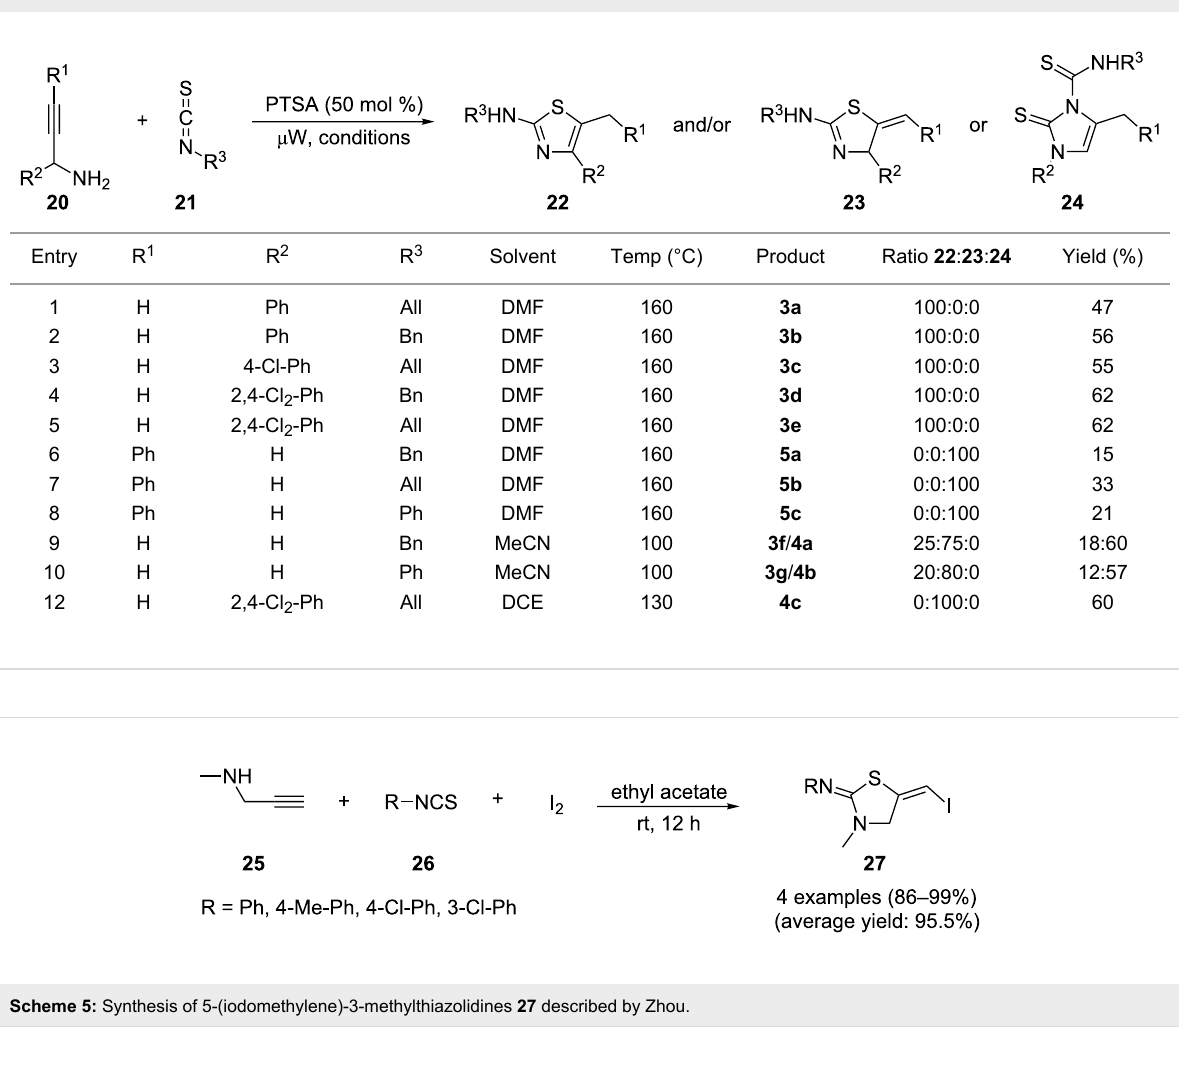
Table 1: Microwave-assisted domino reactions of N -propargylamines 20 with isothiocyanates 21 developed by